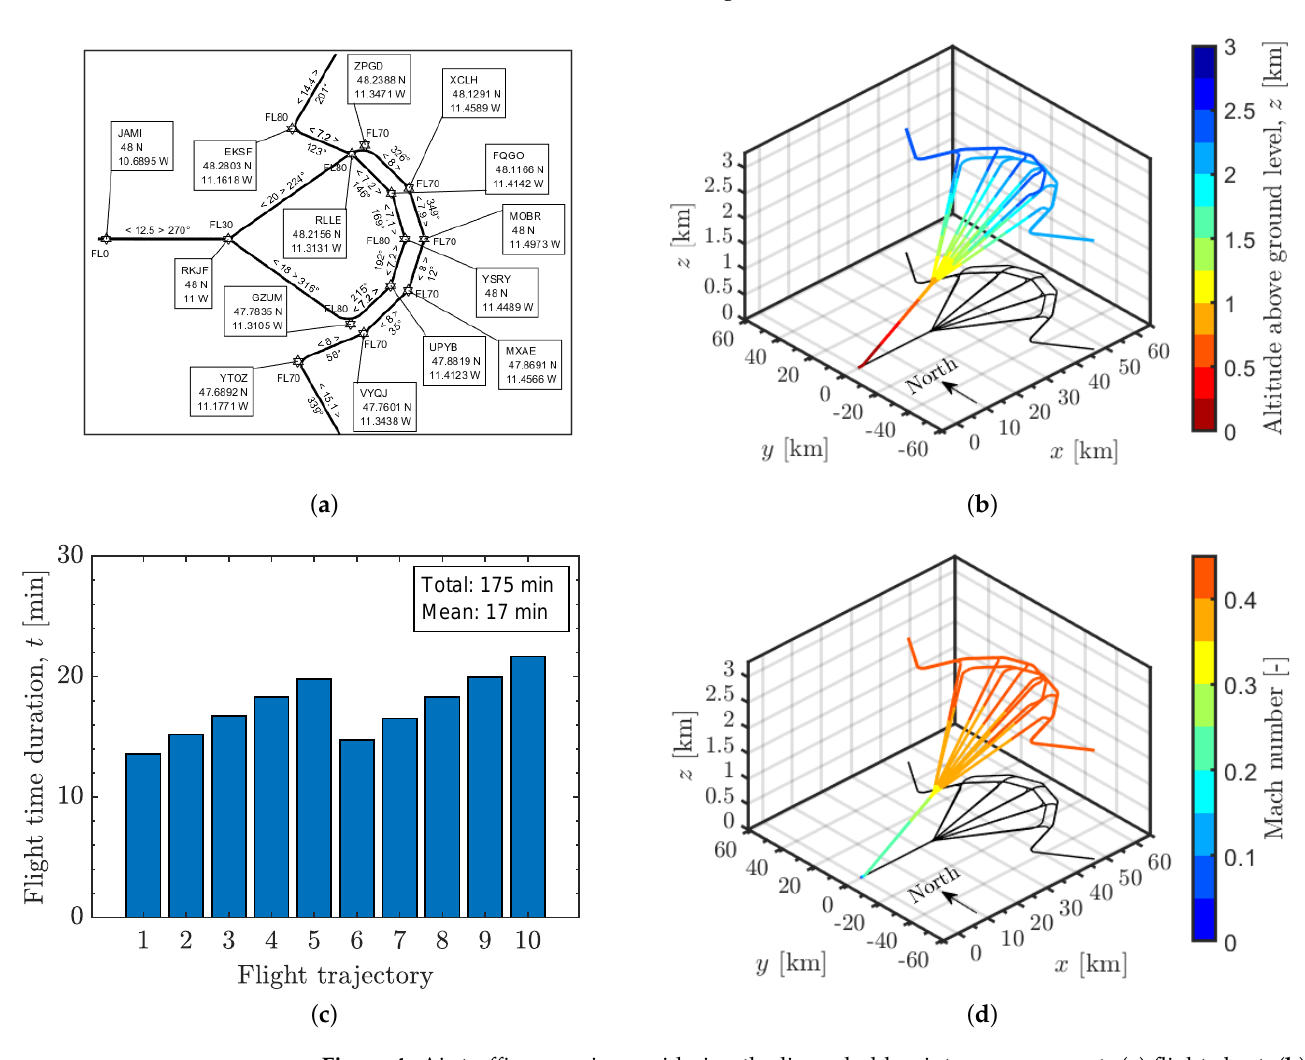
Figure 4. Air traffic scenario considering the linear hold point merge concept: ( a ) flight chart, ( b ) altitude profiles of the flight trajectories, ( c ) total flight time duration per flight trajectory, and ( d ) velocity profiles of the flight trajectories. For the sake of clarity, only flight trajectories calculated based on the performance of the Airbus A320 are